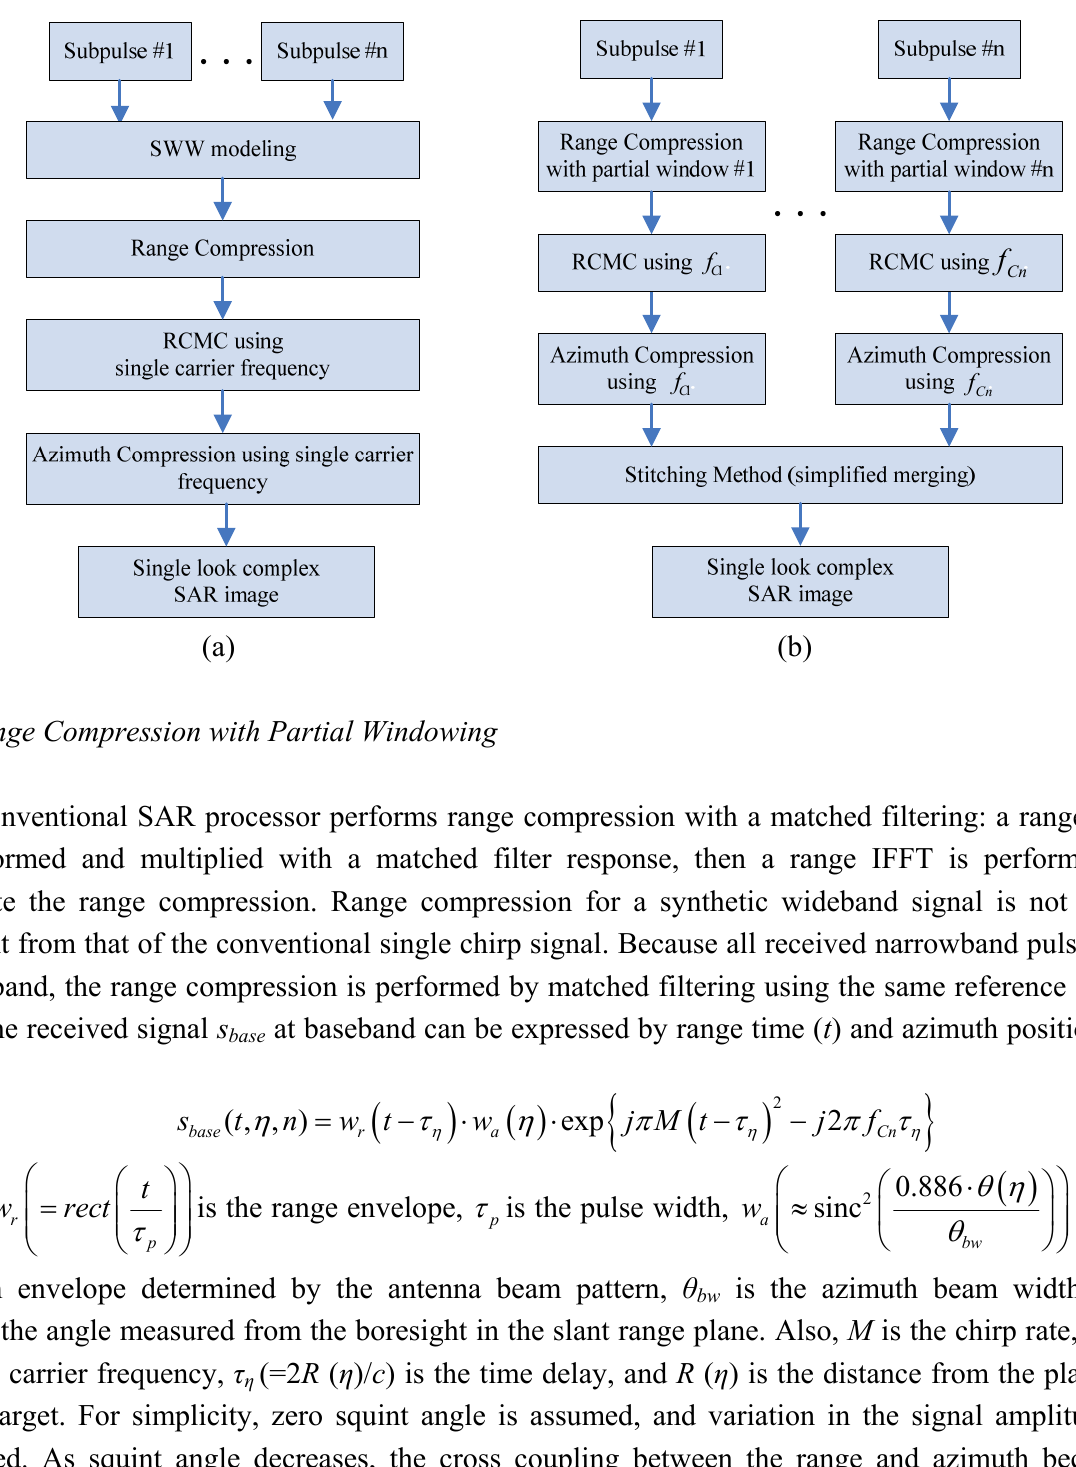
Figure 2. SAR processing algorithm: (a) Conventional algorithm; (b) modified